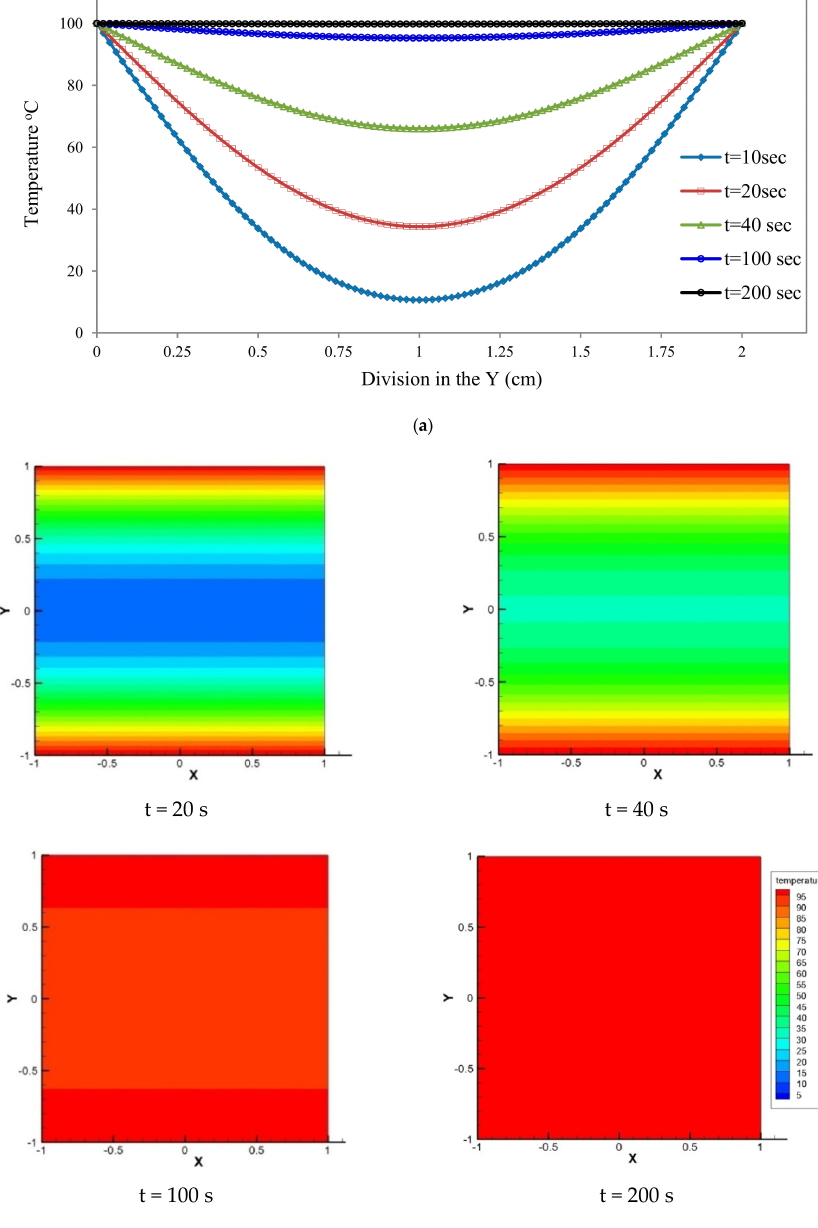
Figure 4. ( a ) 2D temperature variations from PD for symmetric boundary, ( b ) Temperature distribution of 2D plate for symmetric boundary